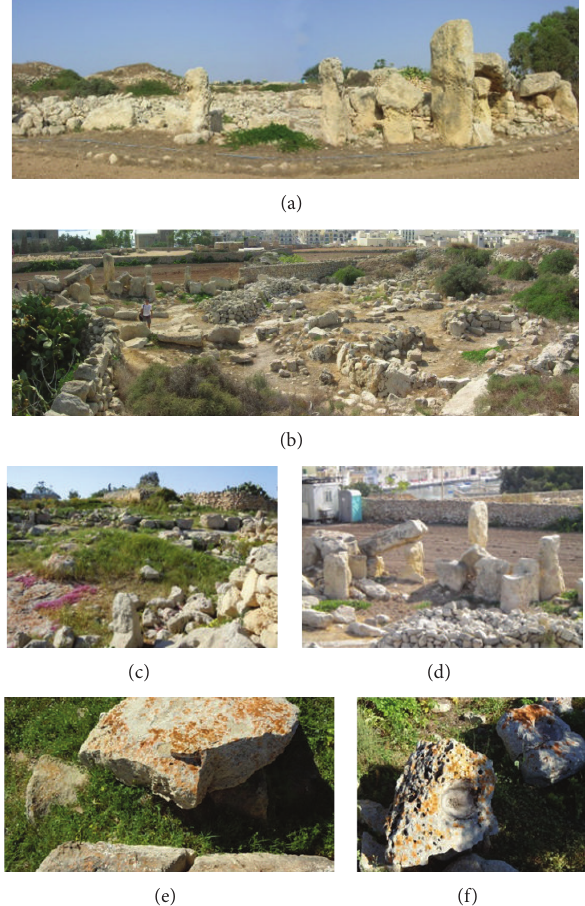
Figure 2: Current conditions of the temple: (a) main entrance to the Forecourt, from the east; (b) overview of the Forecourt and the Apsidal Building, from the west; (c) southern Forecourt and Apsidal Building, from the north; (d) dolmen and Great Upright from west; (e) large biconical pillar, now half buried; (f) grinders grouped together in the southern